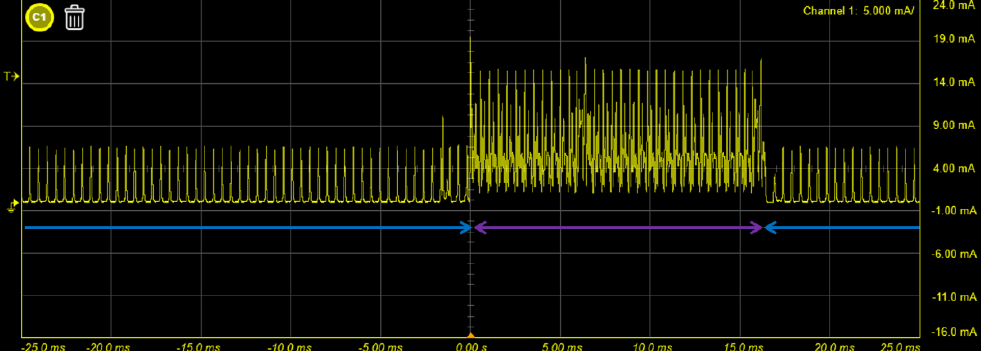
Figure 17. Current consumption of the surface EMG system for small time scales. The blue line is only ADC conversion and the purple line is BLE transmission and ADC conversion.